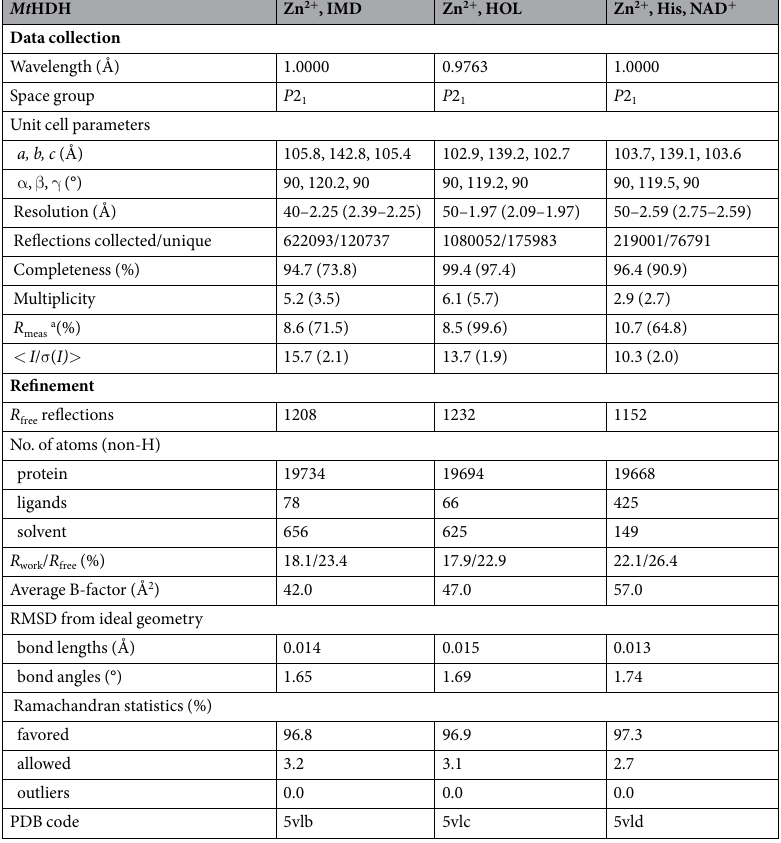
Table 1. Data collection and refinement statistics. Values in parentheses correspond to the highest resolution shell. a R meas = redundancy independent R-factor 60